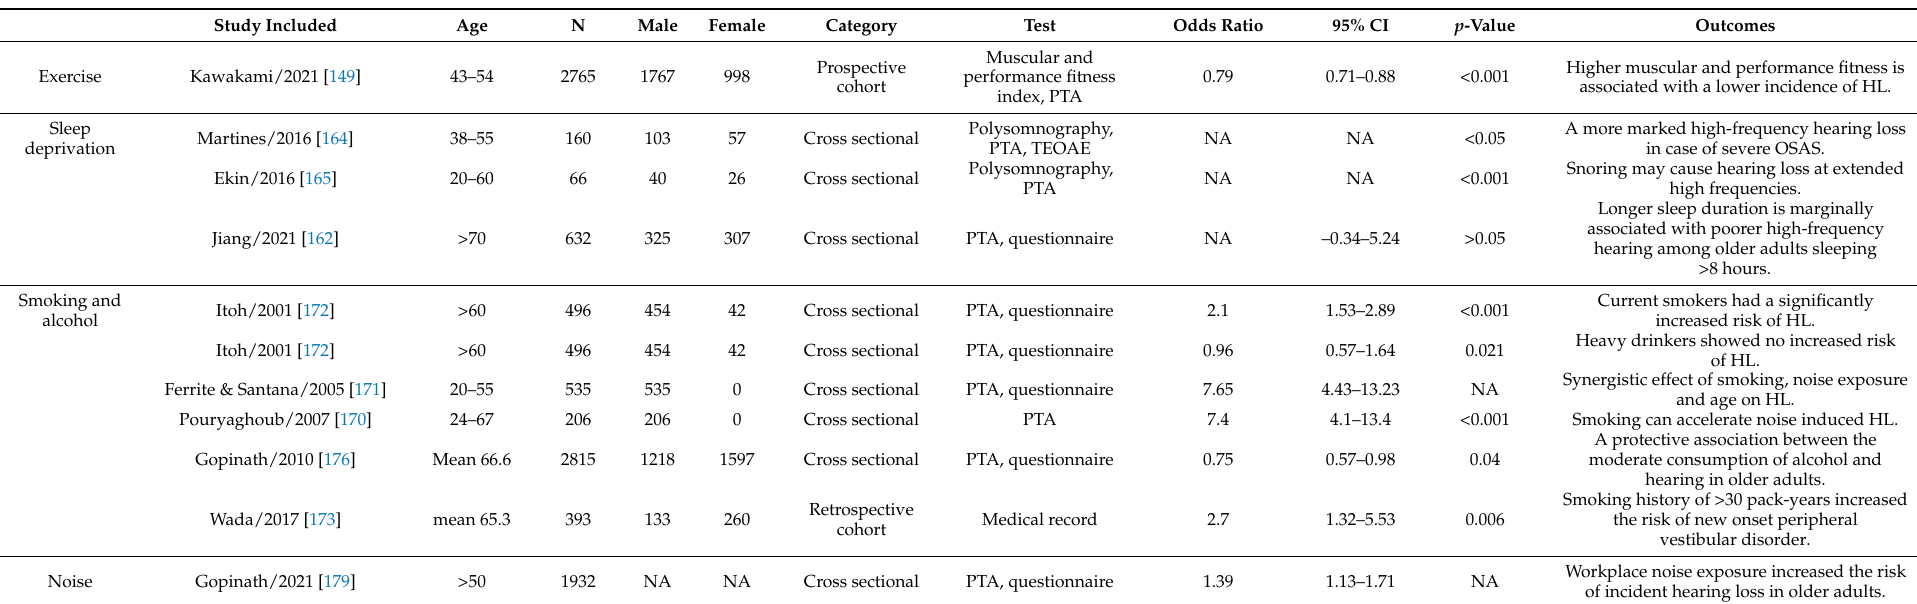
Table 2. The effects of lifestyles on ARHL, ARVL and related